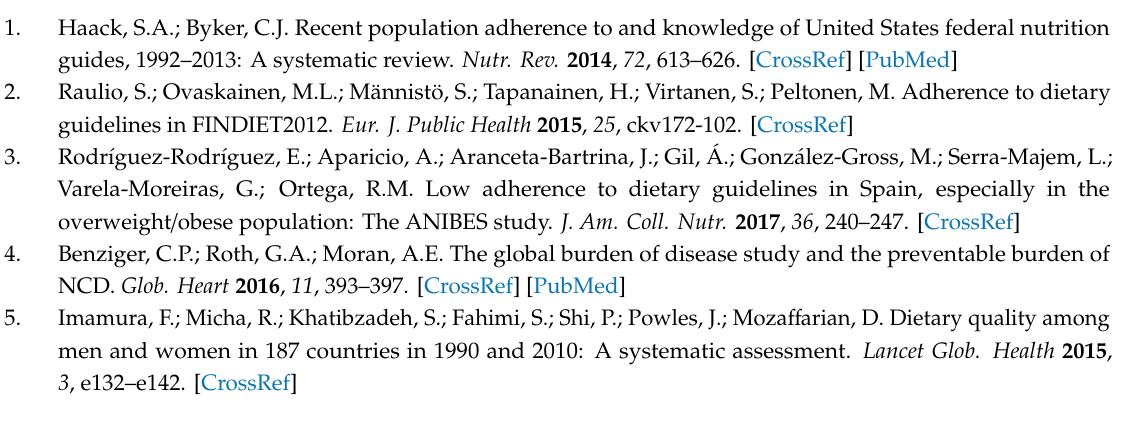
Table S1: The p-values of pairwise comparisons of each of the indicator variables between